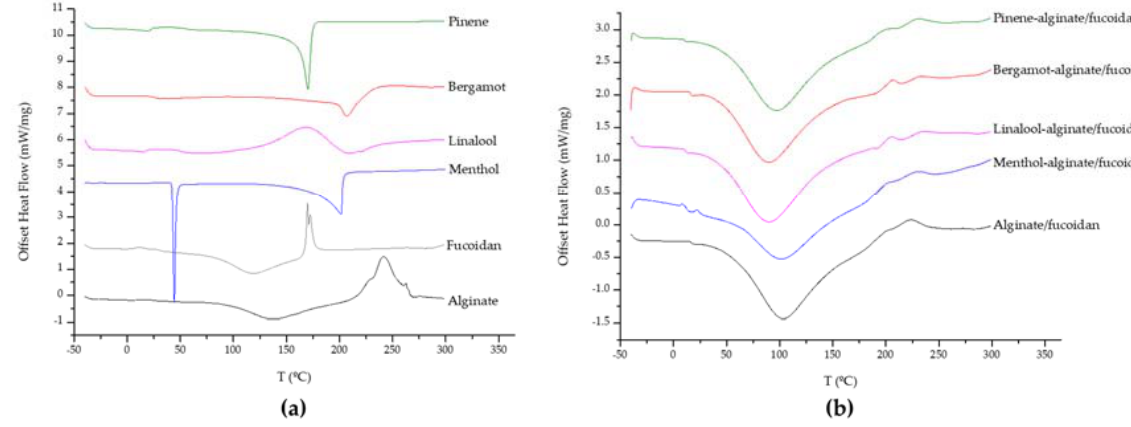
Figure 2. Offset thermograms of hydrogel components ( a ) and all hydrogels ( b ).